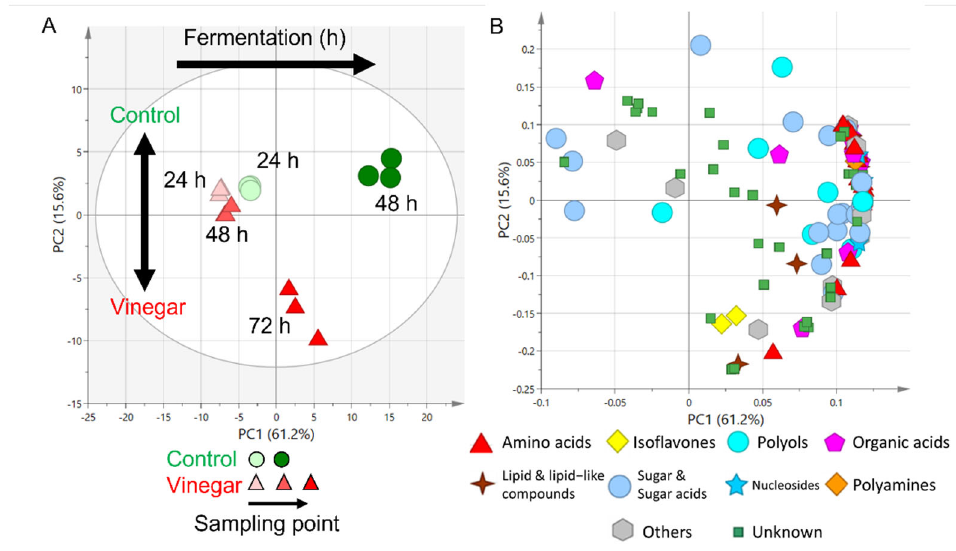
Figure 2. Principal component analysis (PCA) of tempe fermented without and with vinegar for 24 and 48 h, and for 24, 48, and 72 h, respectively. ( A ) Score plot. Circles and triangles of different colors represent tempe soaked without (control) and with vinegar, sampled at various points ( B ) Loading plot. Different shapes and colors represent metabolite classes.